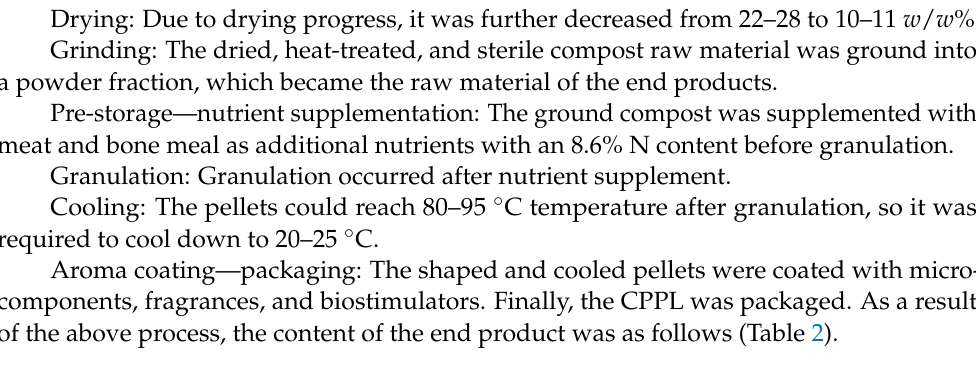
Figure 2. Poultry litter in the Hosoya oval composting tank from storage to the exit